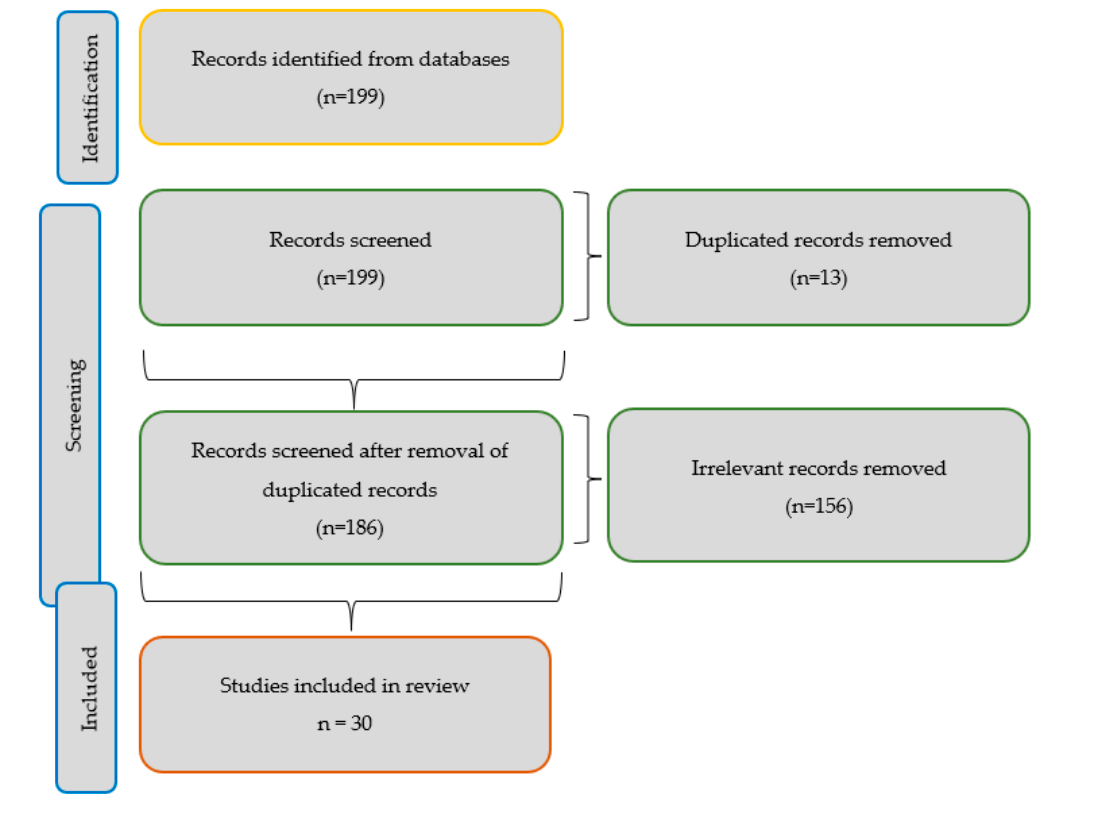
Scheme 1. Flow diagram. Table 2. Databases